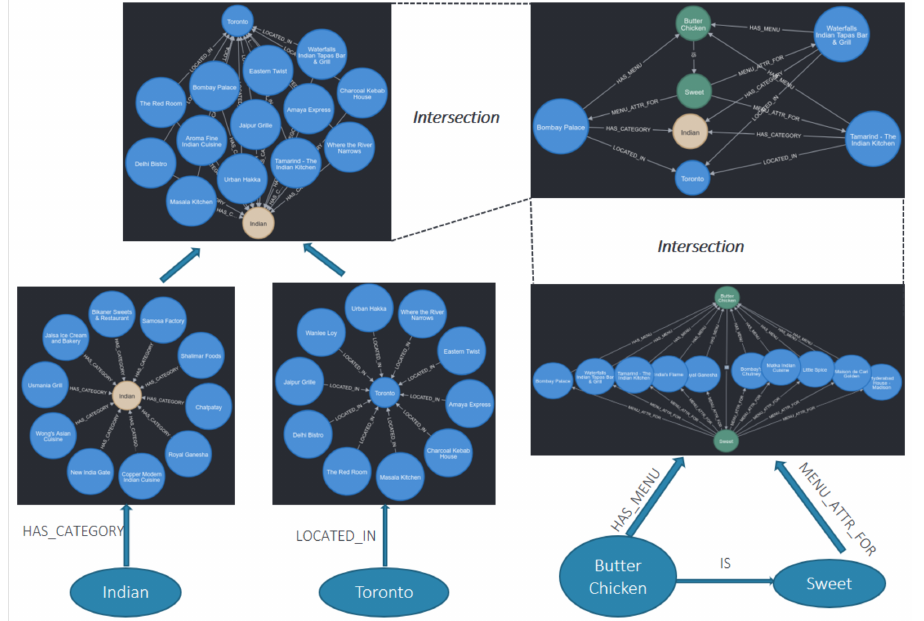
Figure 9. Visual explainable equivalent cypher query result from user Query (1).